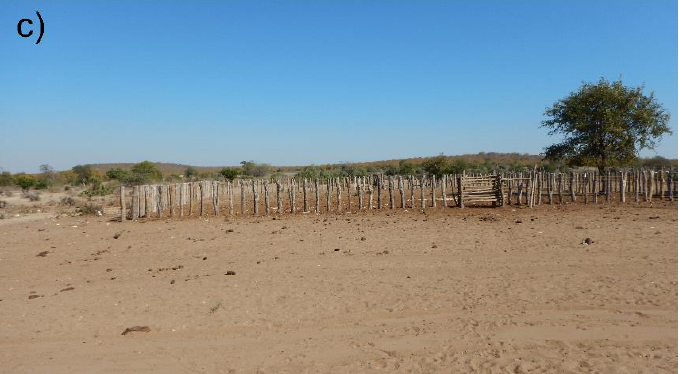
Figure 2. Photos taken in Villages 1 and 2 showing ( a ) a thatch roof building, ( b ) a metal roof building, and ( c ) a corral. Photo credit: Julie A. Silva.